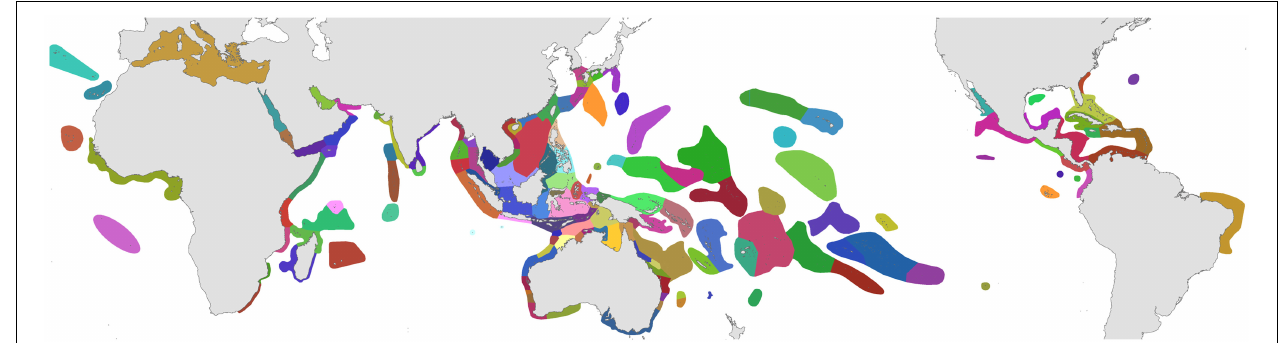
FIGURE 1 | Ecoregionsofcoralsusedinthepresentstudy. EcoregionsoftheCoralTrianglegenerallyaccordwithGreenandMous(2008).Forcoralbiogeographic references consulted, a brief description, and numbers of species in each ecoregion, see Supplementary Material 1: “List of ecoregions and associated